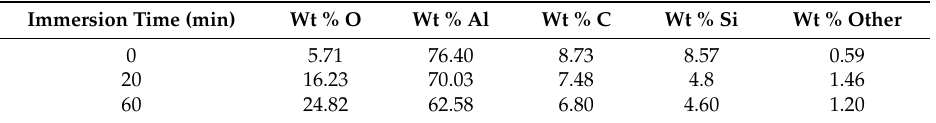
Table 3. EDS analysis of the aluminum substrate surface treated with hot water.